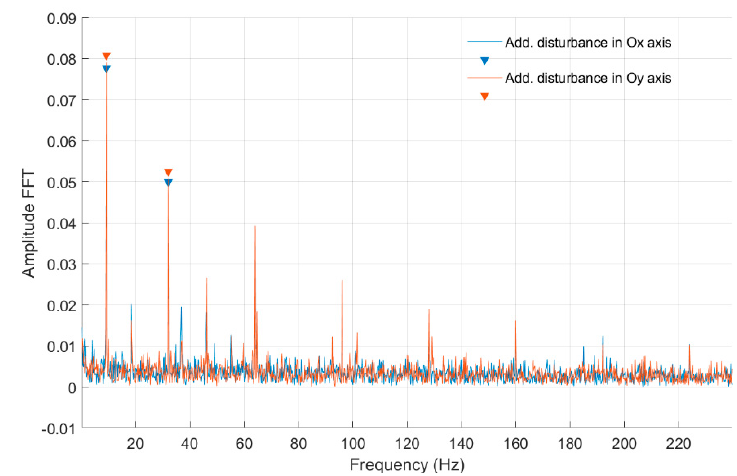
Figure 16. FFT of strain-level measurement for constant motor speed equal to 7 rev/s with disturbance from the control system for a full-bridge configuration (Node 954).